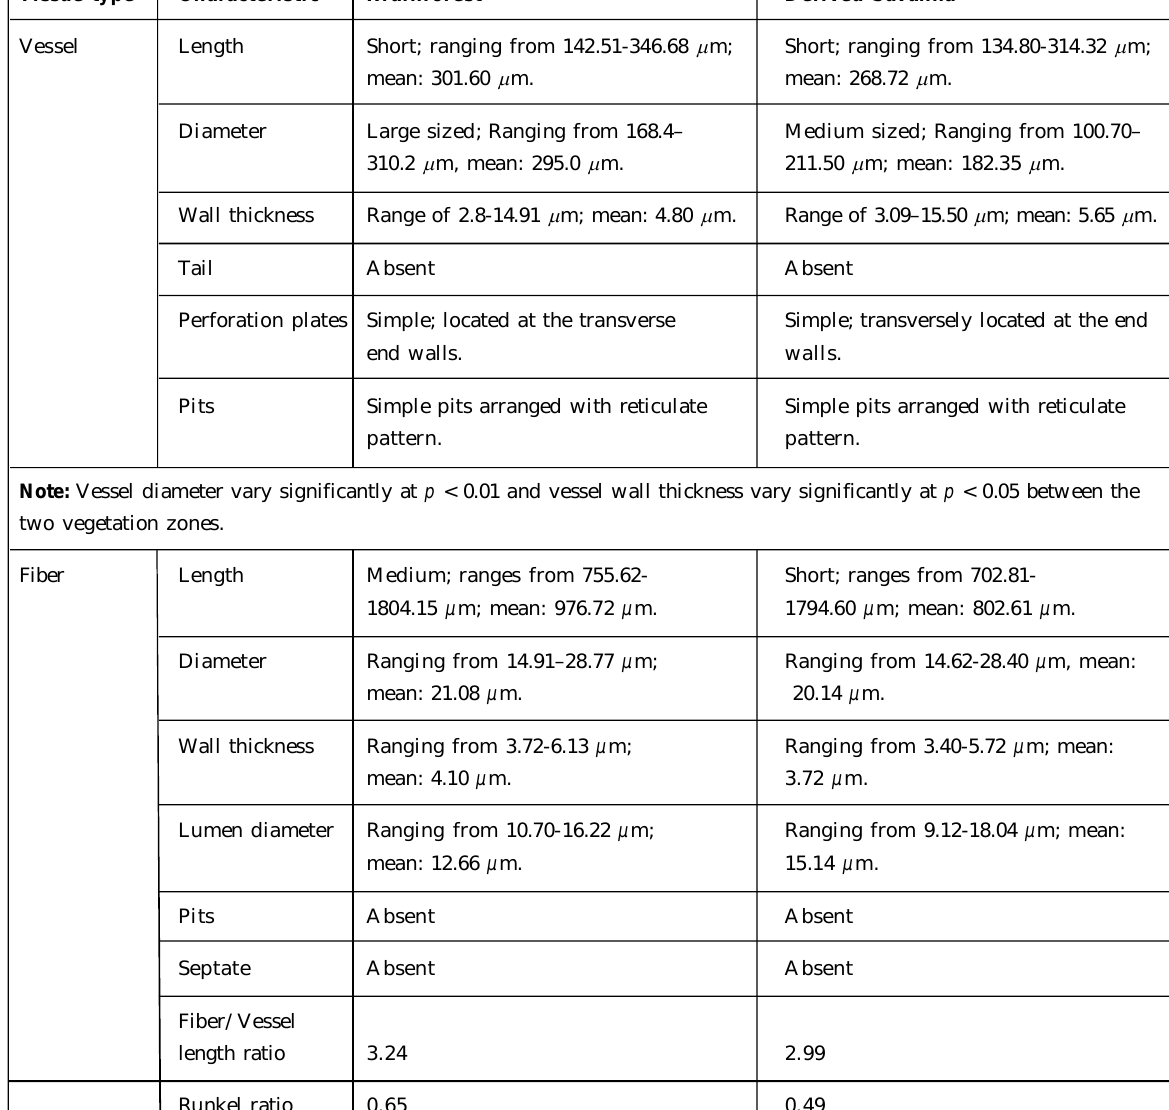
Table 2: Morphological characterization of vessel and fiber elements of Lecaniodiscus cupanoides growing in the rainforest and derived savanna regions of Edo state Tissue